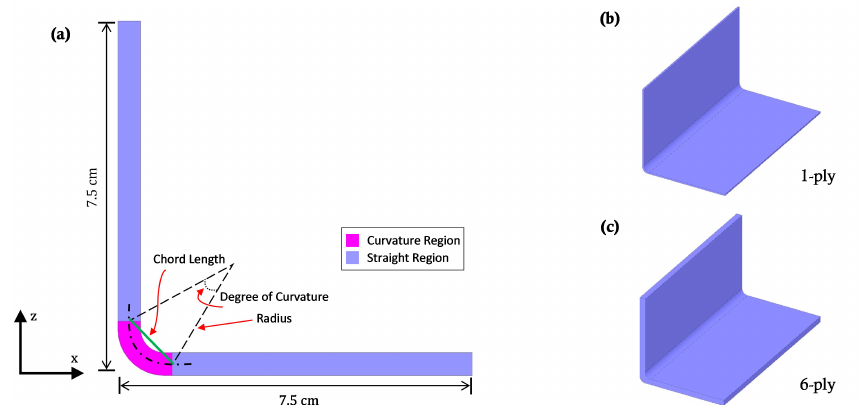
Figure 7. A schematic diagram of ( a ) curvature and straight regions of the L-shaped composite part,